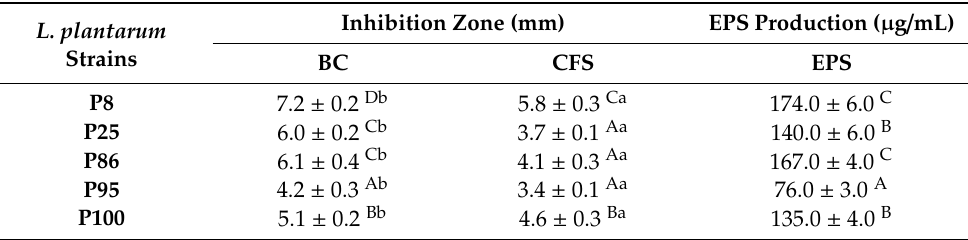
Table 1. Antimicrobial activity (inhibition zone mm) of L. plantarum strains using cultural broths (BC) and cell free supernatants (CFS). Exopolysaccharides (EPS) amounts ( µ g / mL) in MRS broth after 48 h at 37 ◦ C in aerobiosis. Results are shown as mean ± standard deviation ( n = 3). Di ff erent uppercase letters (A–D), in each column, and di ff erent lowercase letters (a,b), in each row, indicate significant di ff erences ( p <